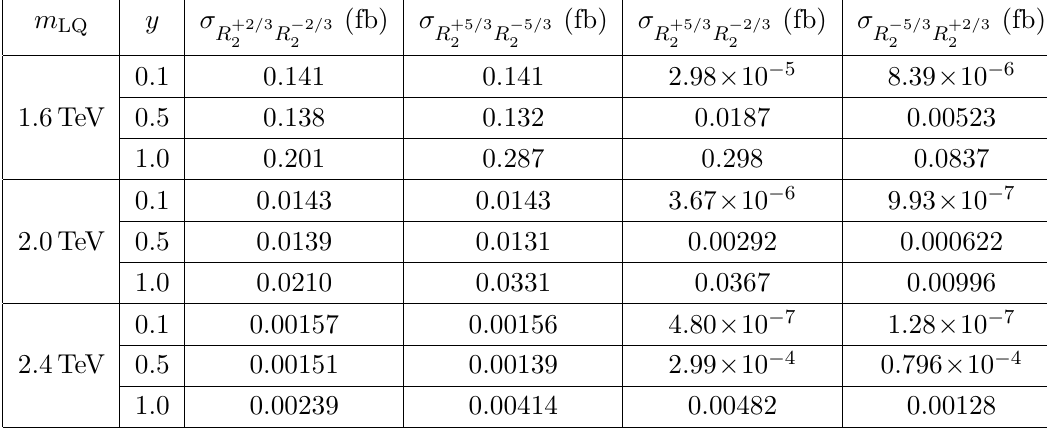
components of mass 2 211